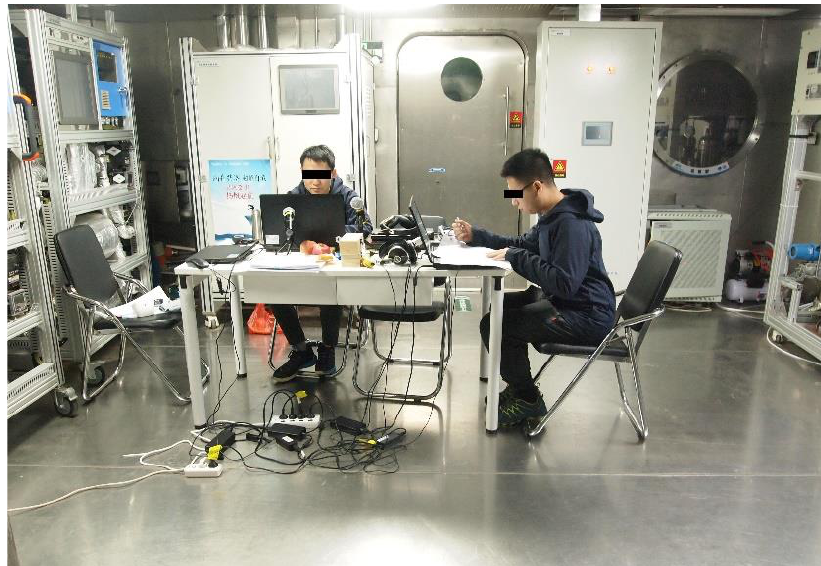
Figure 4. Scenario of sleep deprivation.